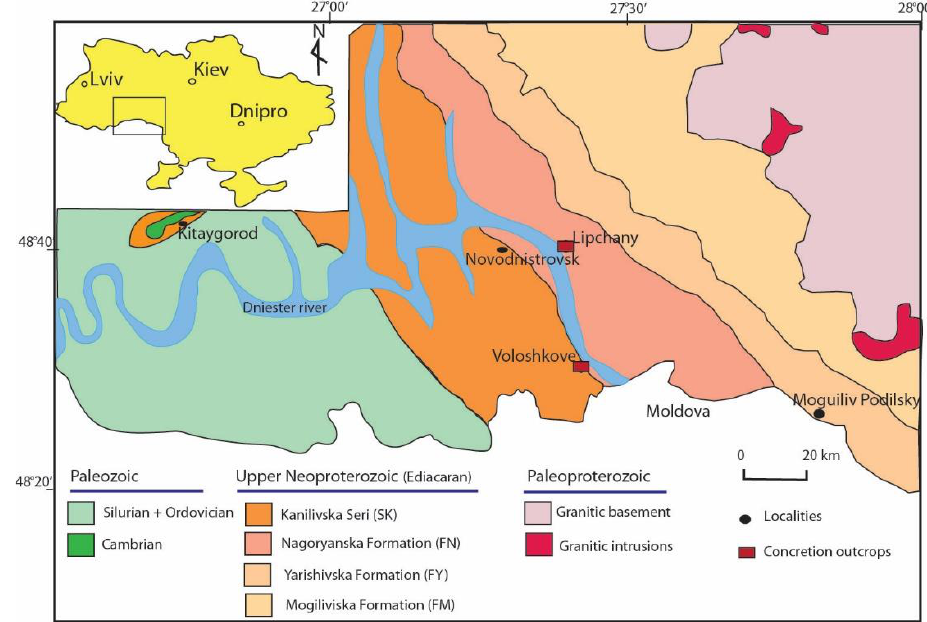
Figure 2. Geological map of the study area and sample locations of phosphate nodules outcrops. Data from [51].